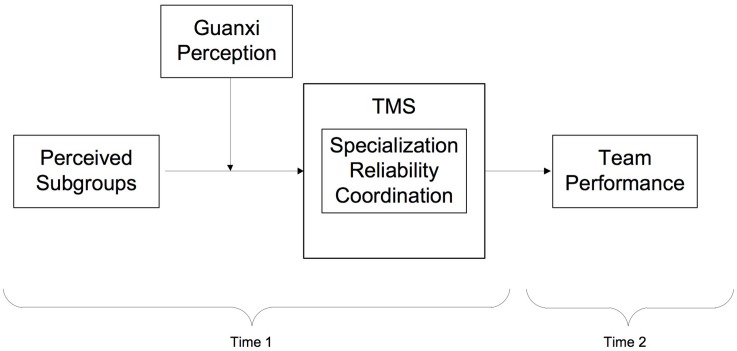
Hypothesized model.